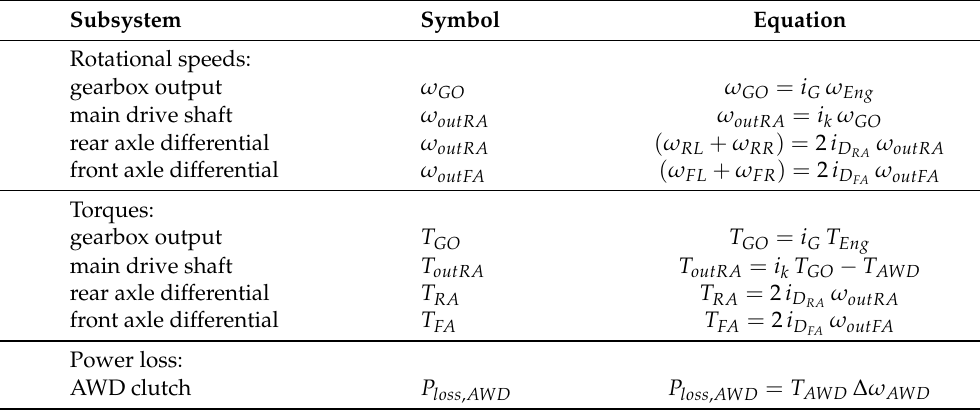
Table 1. Overview and calculation of the rotational speeds and torques in an all-wheel-drive vehicle with torque-on-demand transfer